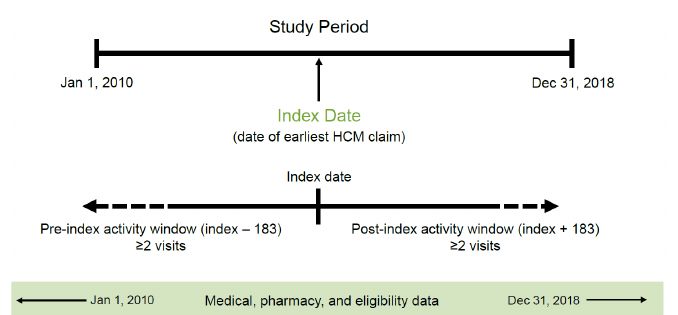
Figure A1. Study time frame. HCM: hypertrophic cardiomyopathy.